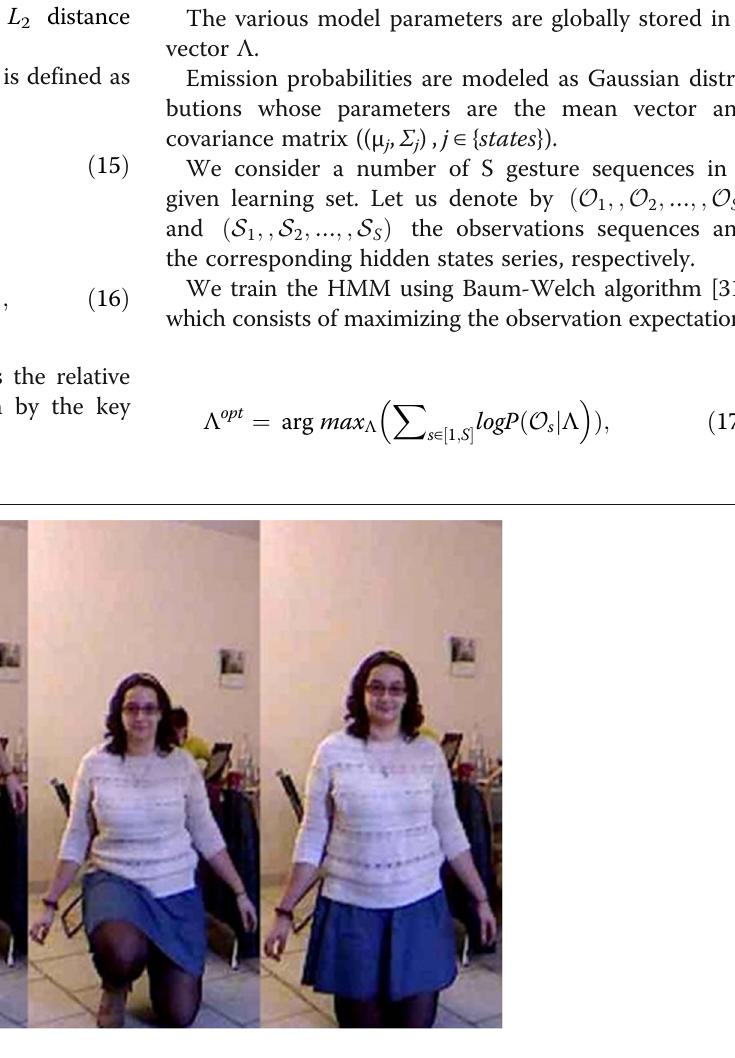
Fig. 3 Execution of kneel gesture by a student